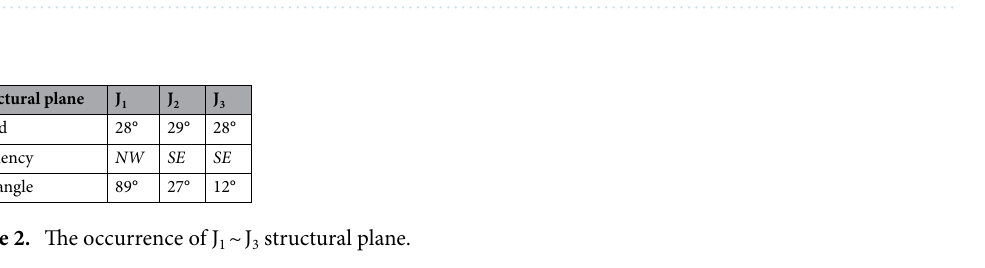
Table 1. Characteristic point coordinates of typical block structural plane.